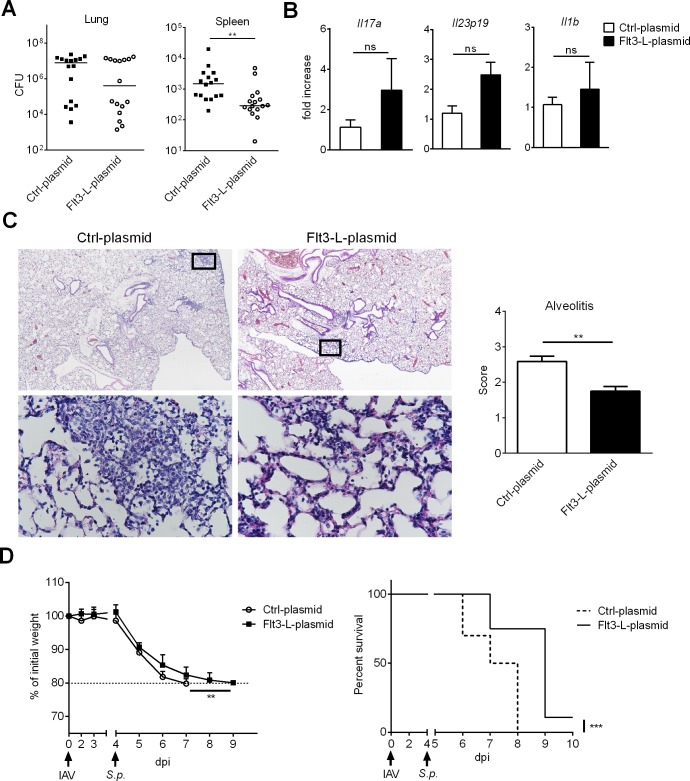
Flt3-L treatment during IAV infection partially protects against secondary pneumococcal infection.Mice were i.v. injected with 2μg of a control- or Flt3-L-encoding plasmid and 24h later, mice were infected with IAV. Four days post-influenza infection, mice were infected with S. pneumoniae (103 CFUs). (A) Mice were sacrificed 30h after S. pneumoniae challenge and the number of CFUs was determined in the lungs and spleen. The solid lines correspond to the median values. Data represent pooled results from two independent experiments (n = 16). (B-C) Mice were sacrificed 12h after S. pneumoniae challenge. (B) mRNA copy numbers of genes encoding Th17-related cytokines were quantified by RT-PCR. All RT-PCR data are normalized to expression of Gapdh and are expressed as fold increase over average gene expression in Ctrl-plasmid/co-infected animals (n = 5). (C) Histological analysis of lung sections. Left panel: Representative lung sections stained with hematoxylin and eosin are shown. Diffuse alveolar inflammation is marked with interstitial thickening in Ctrl-plasmid-treated animals but remains moderate in Flt3-L-treated animals. Lung images are shown at x4 magnification (upper panel) and black squares in lung images are shown at x40 magnification (lower panel). Right panel: Blinded sections were scored for levels of alveolitis. Data represent the means ± SEM (n = 4 mice/group). (D) Body weight evolution (in % initial body weight) (means ± SD) and survival rate of co-infected mice treated or not with Flt3-L were monitored daily (n = 10). **, p < 0.01; ***, p < 0.001, ns: not significative.